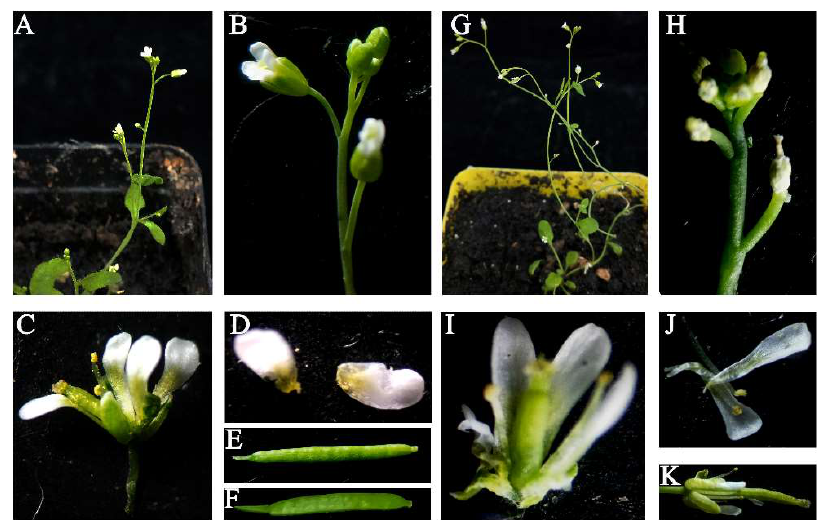
Figure 6. Phenotypes of floral organs in PtoNF-YC8 transgenic Arabidopsis . ( A , G ) WT and PtoNF-YC8 transgenic Arabidopsis plants, respectively. ( B – D ). WT plant floral morphology. ( H – K ) PtoNF-YC8 transgenic Arabidopsis floral morphology. ( E ) WT plant seeds. ( F ) PtoNF-YC8 transgenic plant seeds.